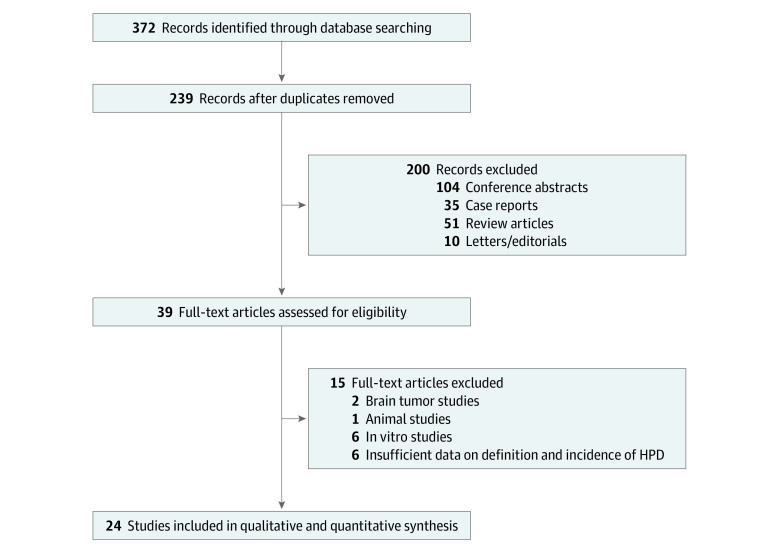
Study Selection ProcessHPD indicates hyperprogressive disease.